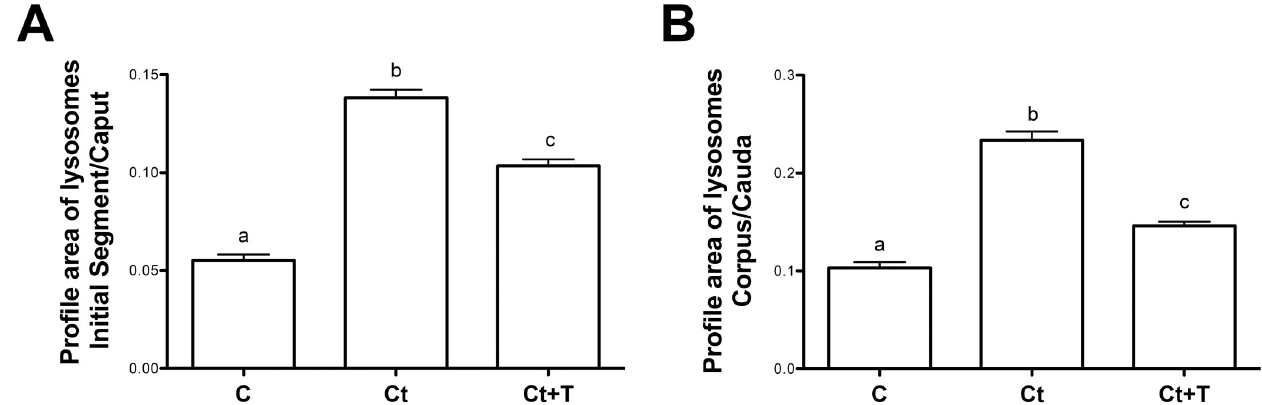
Fig 2. Quantification of lysosomal profile areas of principal cells. Lysosomal profile areas were estimated from digital images obtained by immunocytochemical studies for control (Con), castrated (Ct) and castrated with testosterone supplementation (Ct+T) animals. Calculations were performed on principal cells of the distal IS and proximal caput designated as the IS/Caput region and the distal corpus and proximal cauda designated as the corpus/ cauda region. Bars represent the means of lysosomal profile area per cell ± SEM from three independent experiments for IS/caput (A) and corpus/cauda (B) regions. a, b and c are significantly different from each other (p < 0.0001, obtained by Tukey’s Multiple Comparisons